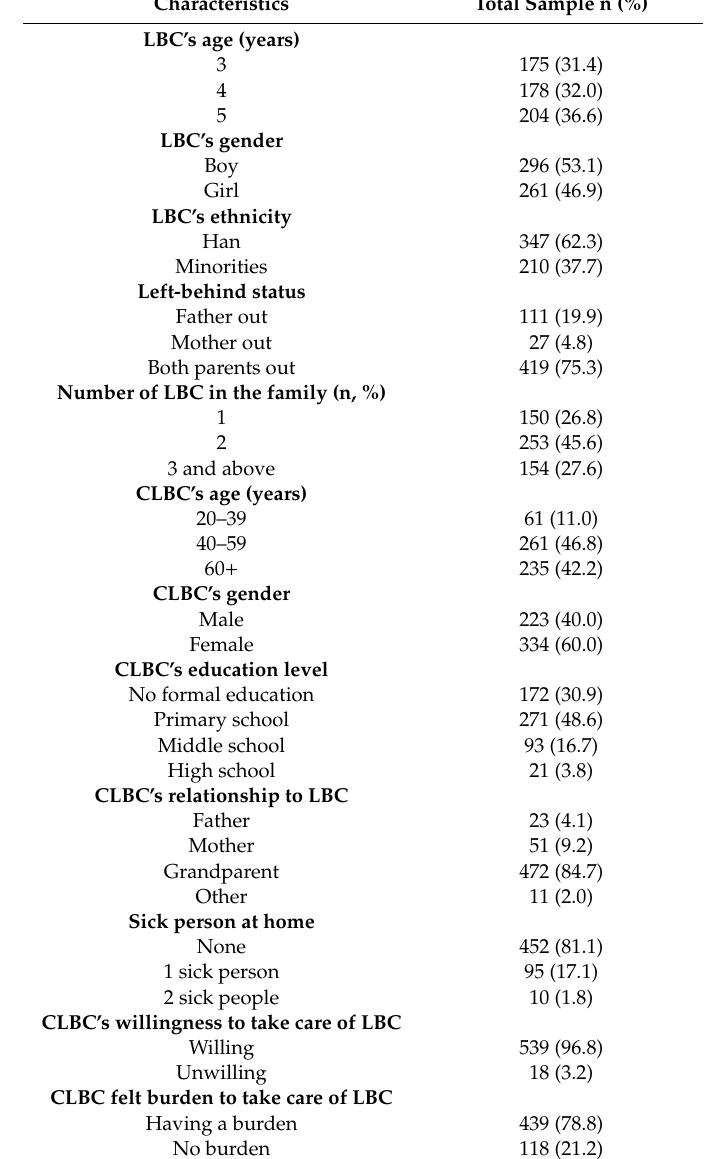
Table 1. Sociodemographic characteristics of the study population (n =